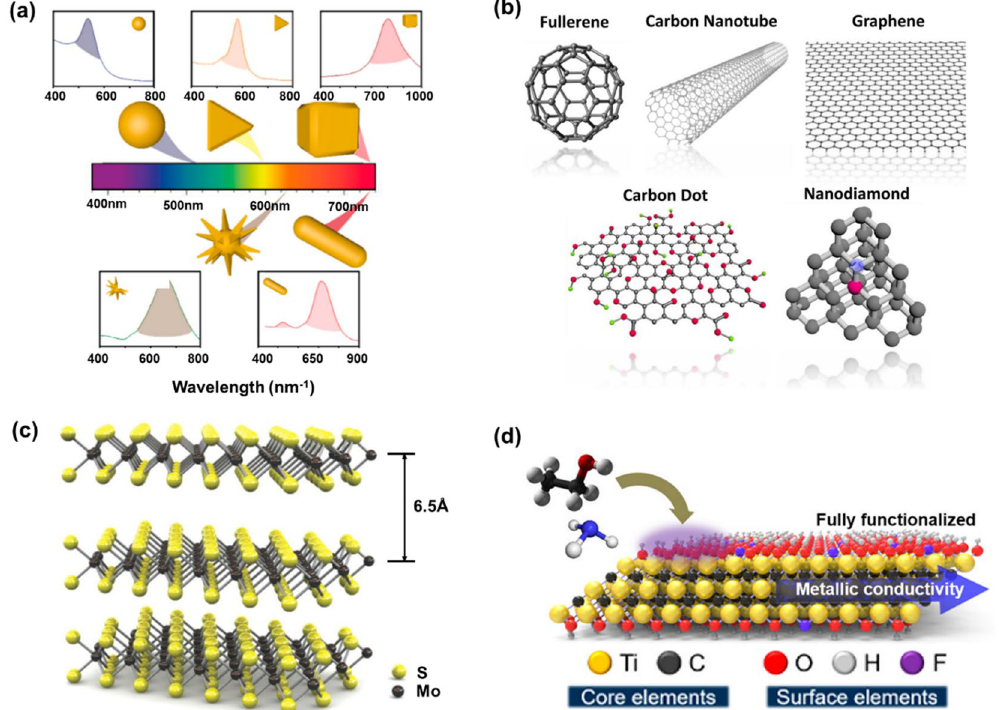
Fig. 2 a Schematic diagram of the localized surface plasmon resonance (LSPR) shift on Au nanomaterials depending on their different shapes (nanosphere, prism, cube, star, or rod). Reproduced with permission from [30], copyright MDPI, 2020. b Schematic images of the structures of representative allotropes of carbon nanomaterials. Reproduced with permission from [34], copyright American Chemical Society, 2015. c Schematic illustration of the crystal structure of MoS 2 , which consists of a transitional metal (Mo) atomic layer sandwiched between two chalcogen (S) atomic layers. Reproduced with permission from [37], copyright American Chemical Society, 2015. d Schematic illustration of the atomic structure and constituting elements of the Ti 3 C 2 T x MXene. Reproduced with permission from [39], copyright American Chemical Society,